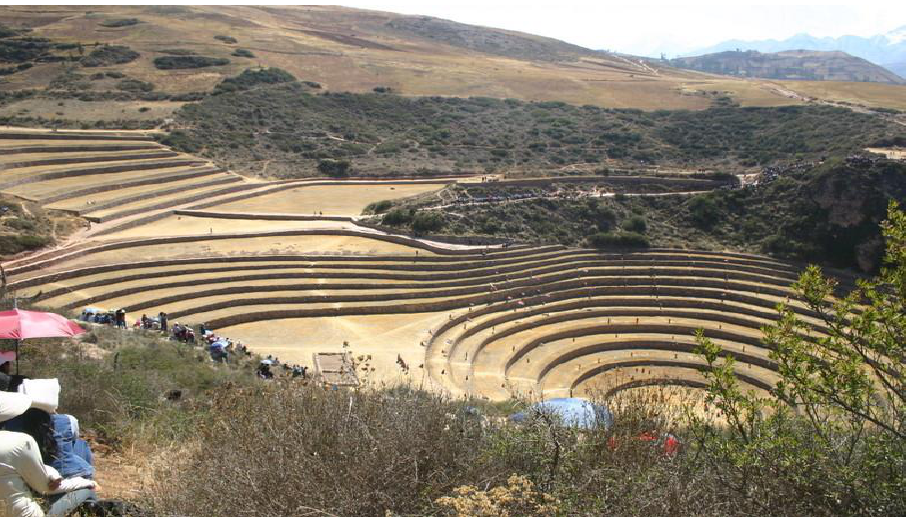
Figure 20. The Inka agricultural platform system at the site of Moray located some ~15 km southwest of the Cuzco area. (Photo by C. Ortloff)